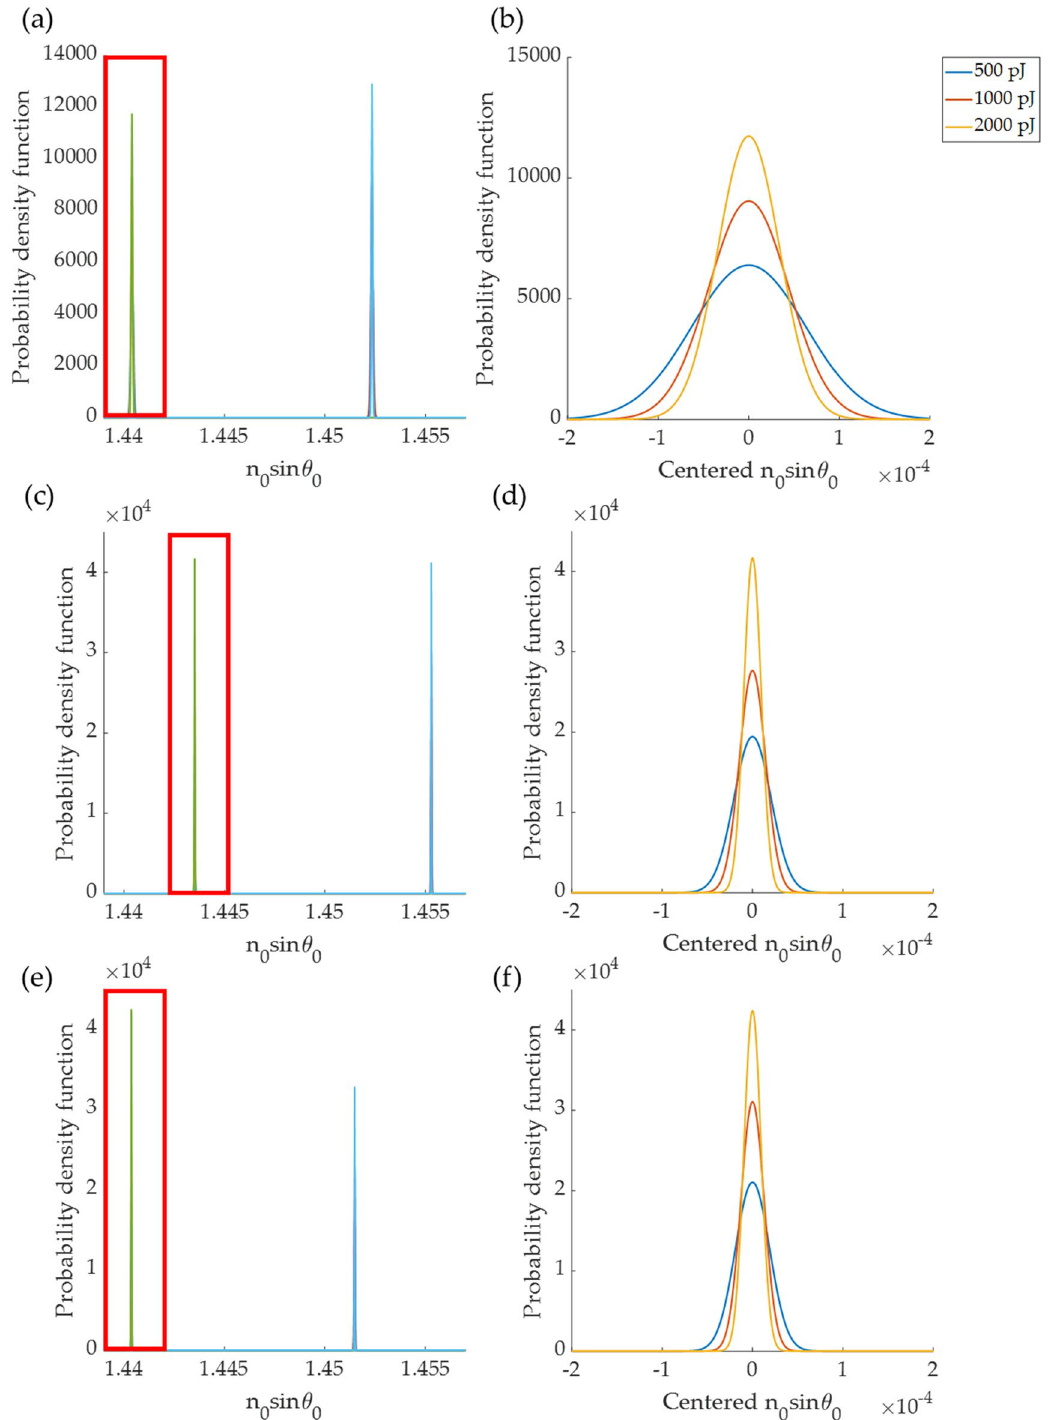
Figure 12. Shows probability density functions of plasmonic dip positions for different photon energy levels of 500 pJ, 1000 pJ, and 2000 pJ calculated for 3 plasmonic dip measurement methods. ( a ) 3rd-degree polynomial curve fitting in intensity line scan image, ( b ) zoomed-in curves of ( a ) in the highlighted curves, ( c ) 45-degree azimuthal averaging, ( d ) zoomed-in curves of ( c ) in the highlighted curves, ( e ) the DL-based method, and ( f ) zoomed-in curves of ( e ) in the highlighted